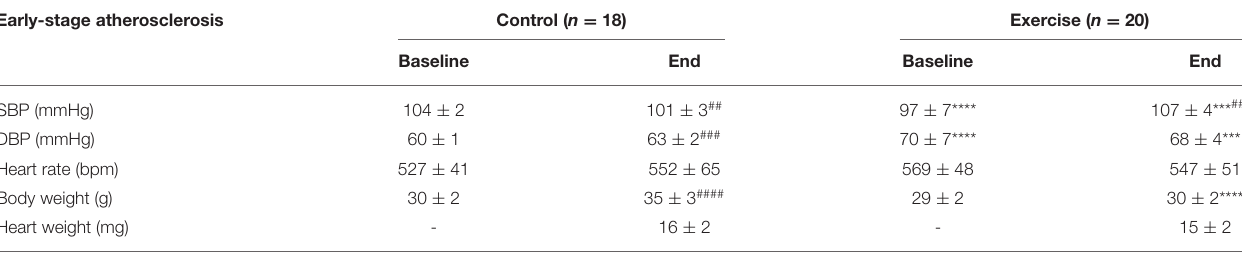
TABLE 1 | The effect of exercise on clinical parameters of the early-stage atherosclerosis mouse model. Early-stage atherosclerosis